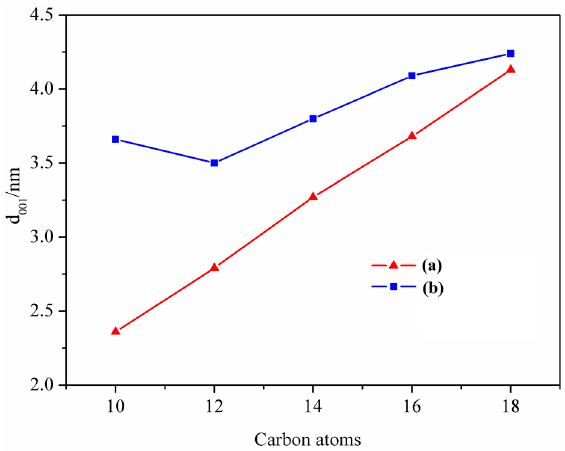
Figure 2. Relation curves of basal spacing and number of carbon atoms in the alkyl chain: ( a ) kaolinite/fatty acid intercalation compounds (K-Fas); ( b ) kaolinite/quaternary ammonium salts intercalation compounds (K-Qas).